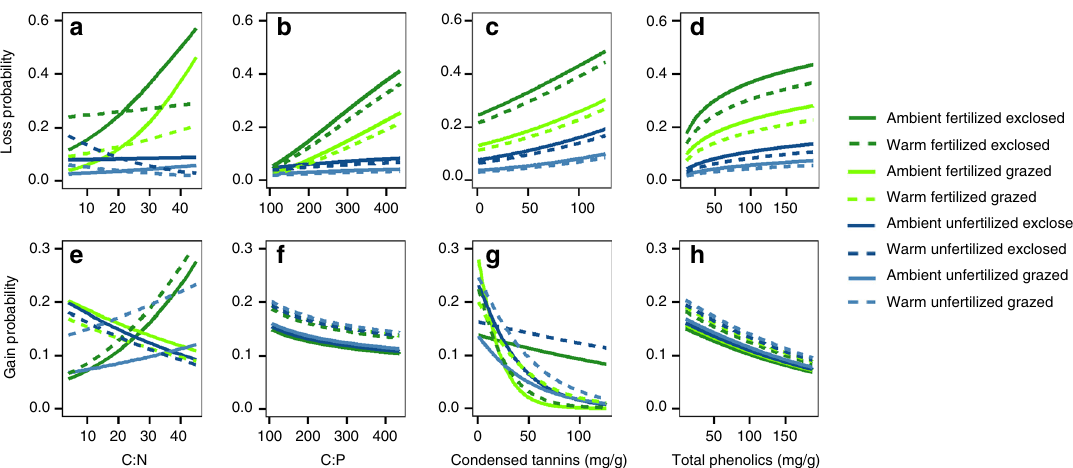
Fig. 5 Impacts of leaf chemistry traits on probabilities of species losses and gains. Modeled probability of species ’ losses and gains as functions of carbon: nitrogen ratio (C:N, a , e ), carbon:phosphorus ratio (C:P, b , f ), condensed tannins c , g and total phenolics d , h under combinations of warming, grazing and fertilization treatments. Fertilized plots are shown in green , unfertilized in blue . Herbivore exclosures are indicated with dark color , grazed plots in light color . Dashed line indicates prediction for warmed plots, solid line for unwarmed (with ambient temperature). Modeling results can be found in